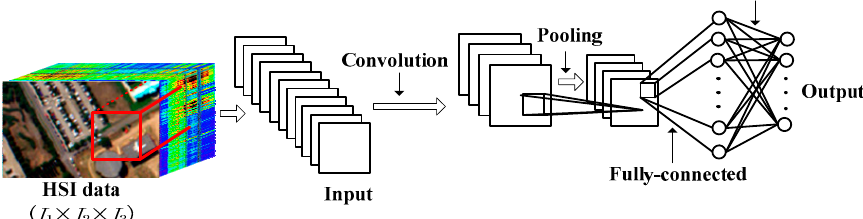
Figure 1. Framework of a three-dimensional convolutional neural network (3D-CNN).